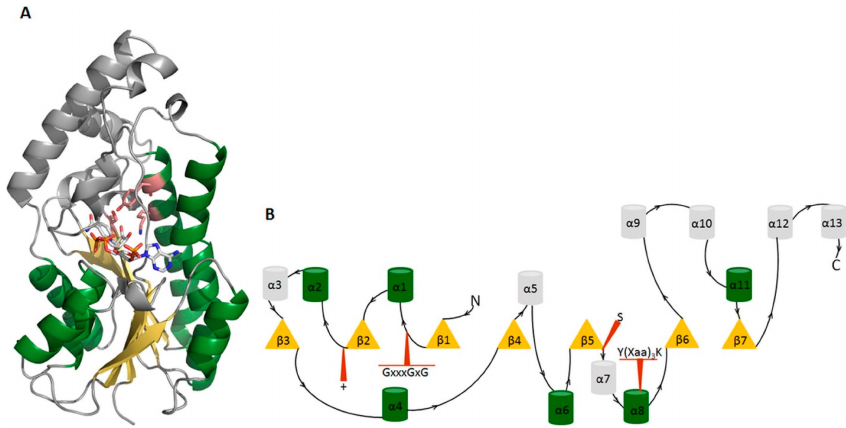
Figure 5. The general structure of SDR enzymes exemplified on 17 β -HSD1 (PDB entry 1EQU [5]). ( A ) The Rossmann fold consists of parallel stranded β -sheets (yellow), which are flanked by α -helices on both sides (green). This structural domain forms the binding site of the co-factor NADP+. The residues Tyr155 and Lys159 of the Tyr-(Xaa)3-Lys motif as well as the conserved Ser142 are highlighted in rose; ( B ) 2D depiction of 17 β -HSD1 (PDB entry 1EQU). Yellow triangles display β -sheets and barrel symbols α -helices. Apart from the Rossmann fold, structurally conserved regions are highlighted in red. The conserved glycine-rich motif GxxxGxG is important for cofactor binding and the + indicates a positive charged residue crucial for cofactor (NADP+) stabilization.